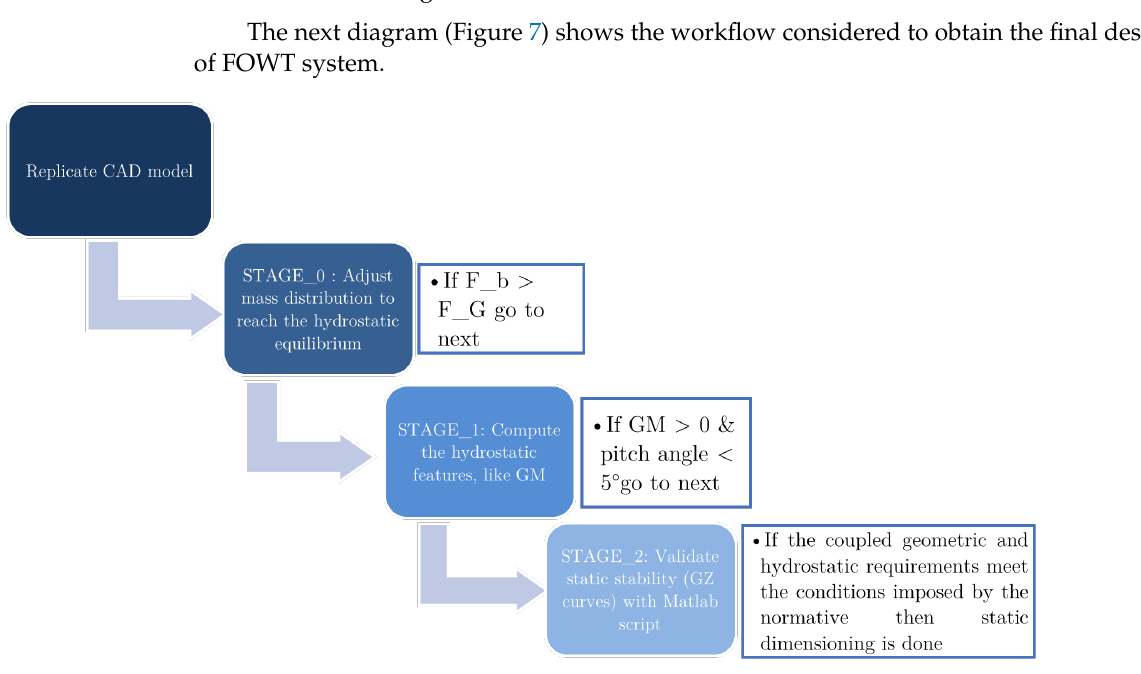
Figure 7. Workflow of the hydrostatic